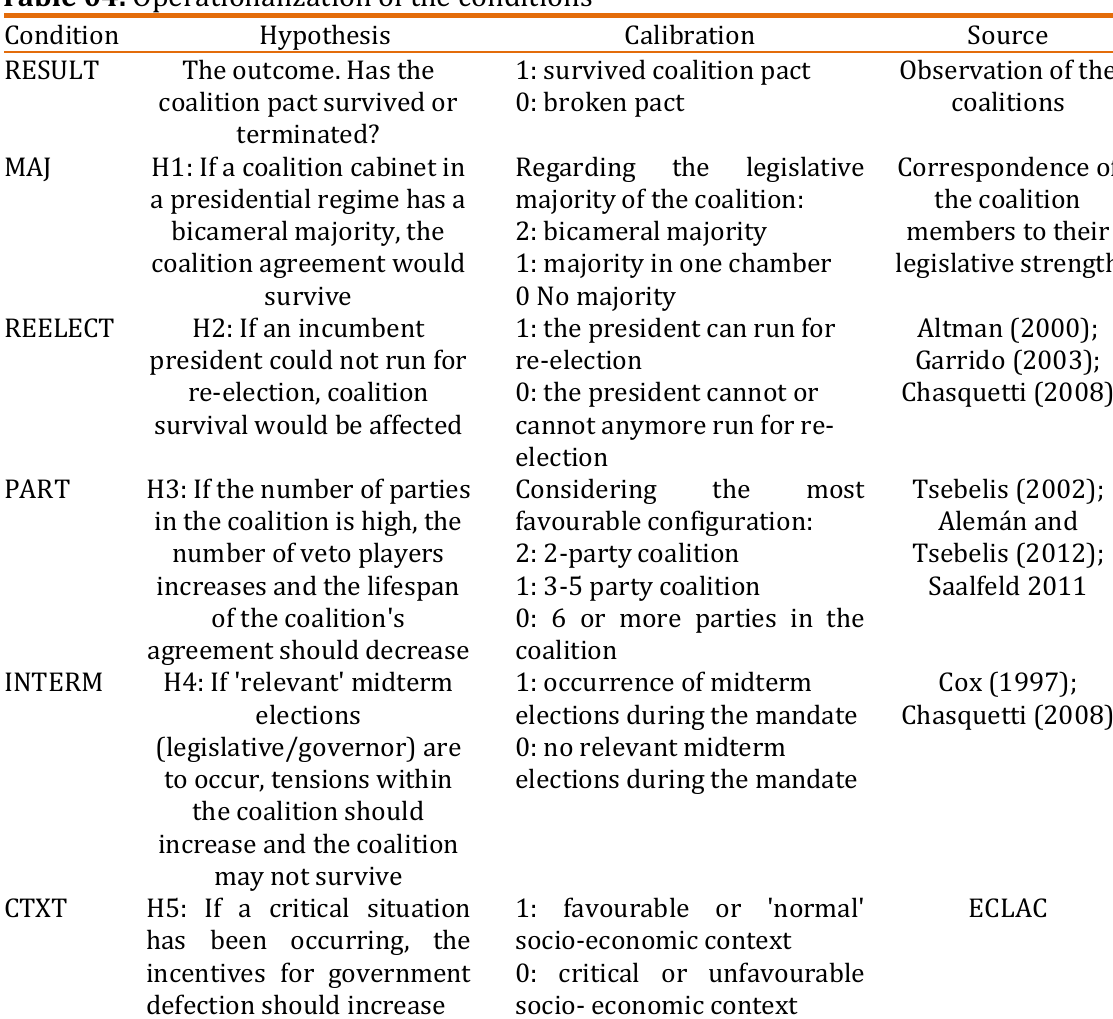
Table 04. Operationalization of the conditions